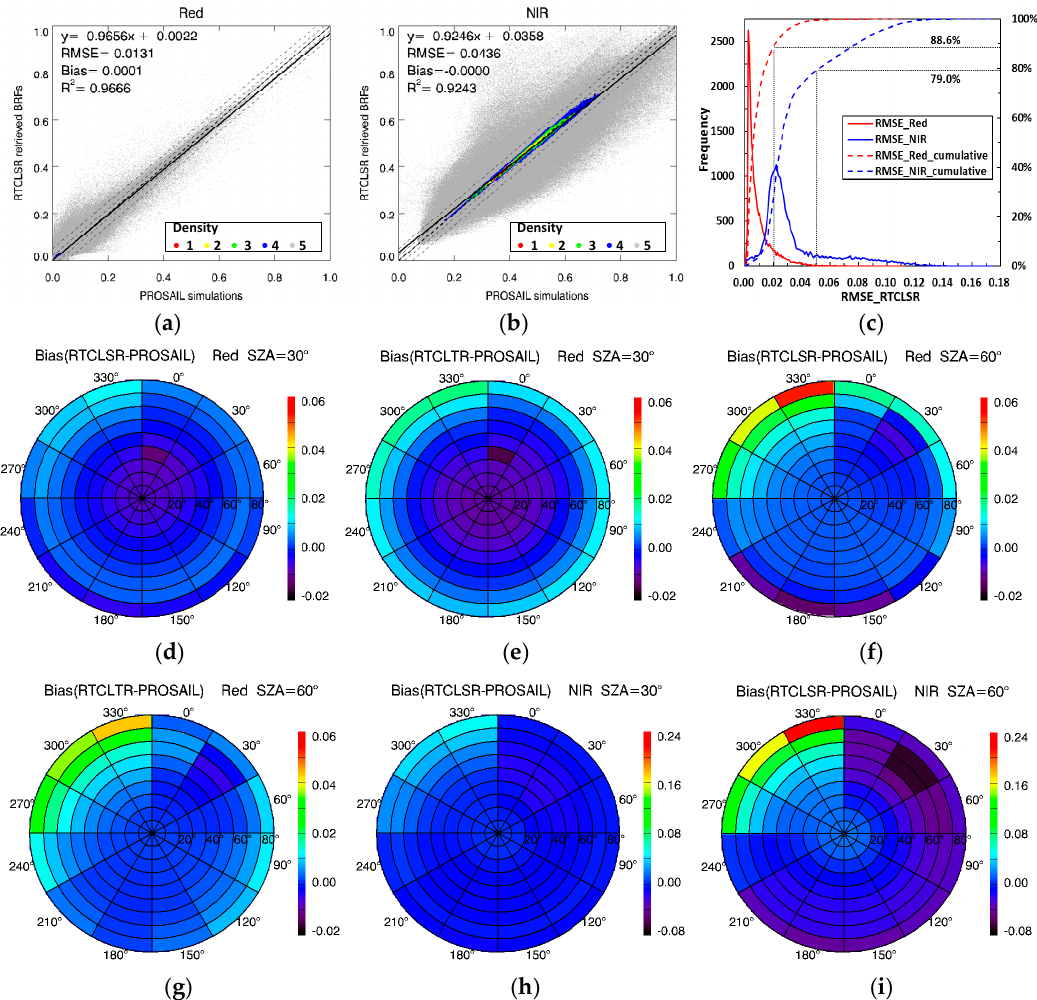
Figure 3. Comparison of the directional reflectances between the PROSAIL simulation and RTCLSR inversion in the red and NIR bands for diverse canopies, where the two gray dashed lines show the 0.02 and 0.05 tolerances: ( a , b ) comparison of the directional reflectances of five equal density levels from 1 (maximum) to 5 (minimum) and ( c ) histogram of fit-RMSE. ( d – g ) refer to the distribution of average biases of BRFs between the two models for the red band, where SZAs of 30 ◦ and 60 ◦ are involved. ( h , i ) refer to the similar results as ( d ) and ( f ) but for the NIR Table 3. The AFX and fit-RMSE statistics between the RTCLSR/RTCLTR and PROSAIL models for